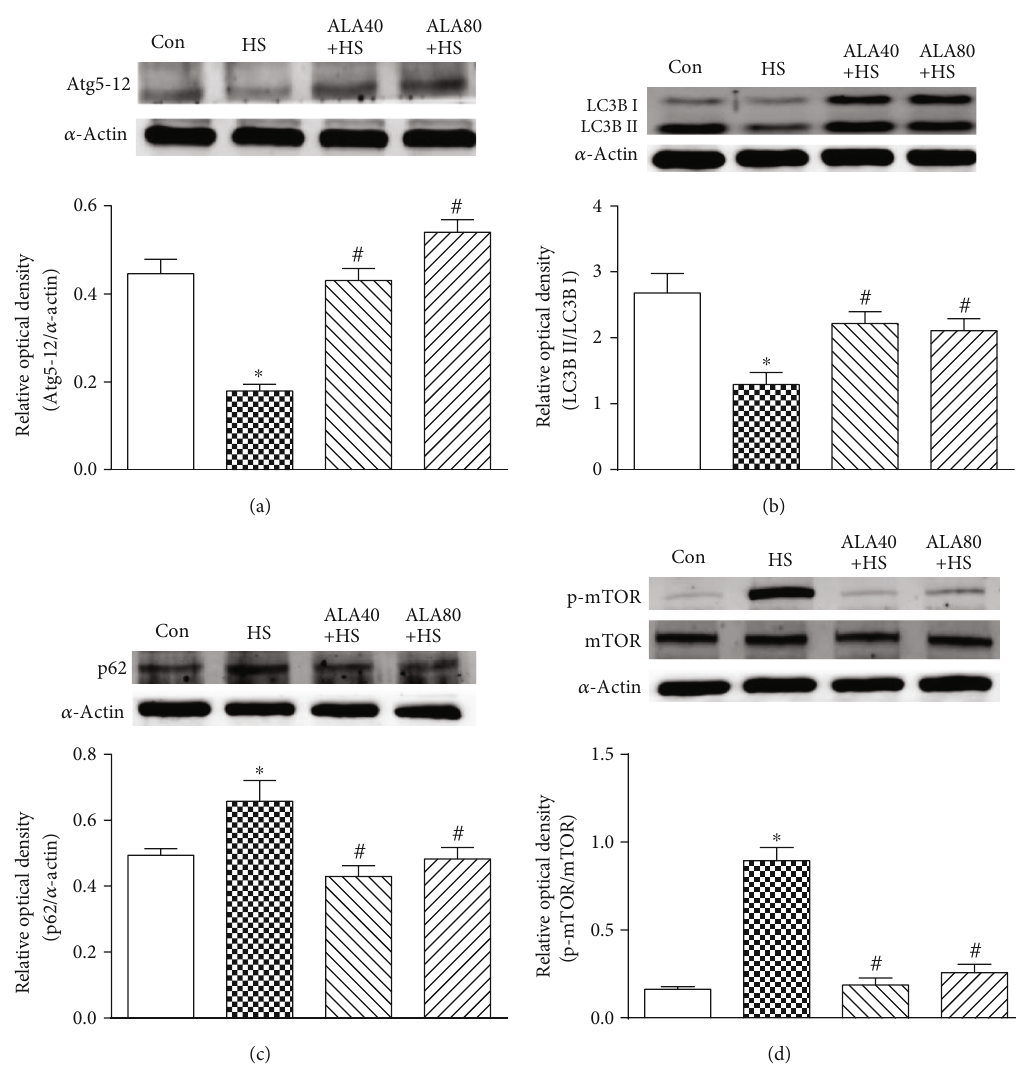
Figure 7: E ff ects of pretreatment with α -lipoic acid (ALA) on (a) Atg5-12, (b) LC3B, (c) p62, and (d) mTOR protein expression in the myocardium of heat stroke rats. Data are expressed as mean ± SEM ( n = 5 -8). ∗ P < 0 : 05 versus Con; # P < 0 : 05 versus